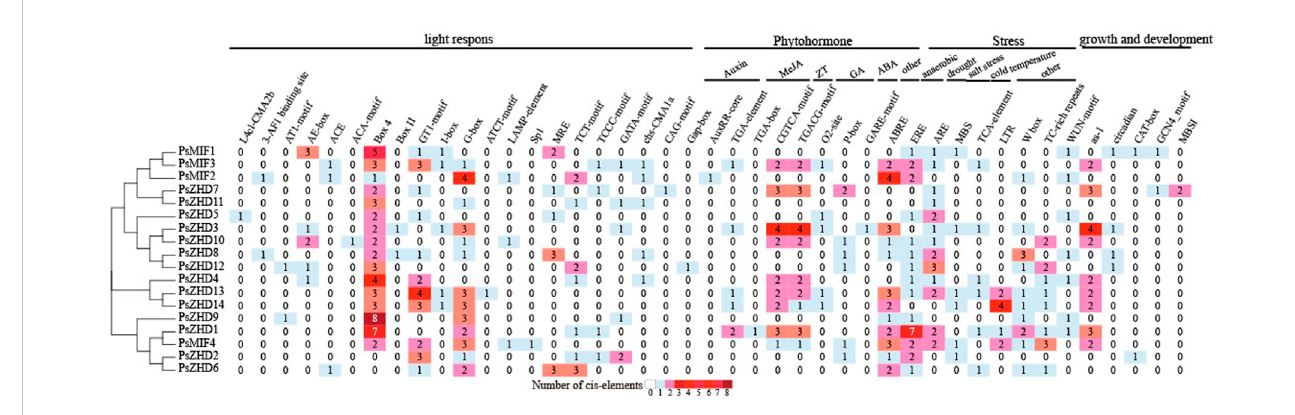
FIGURE 4 Analysis of Cis-acting elements of ZF-HD gene family in P. sative .